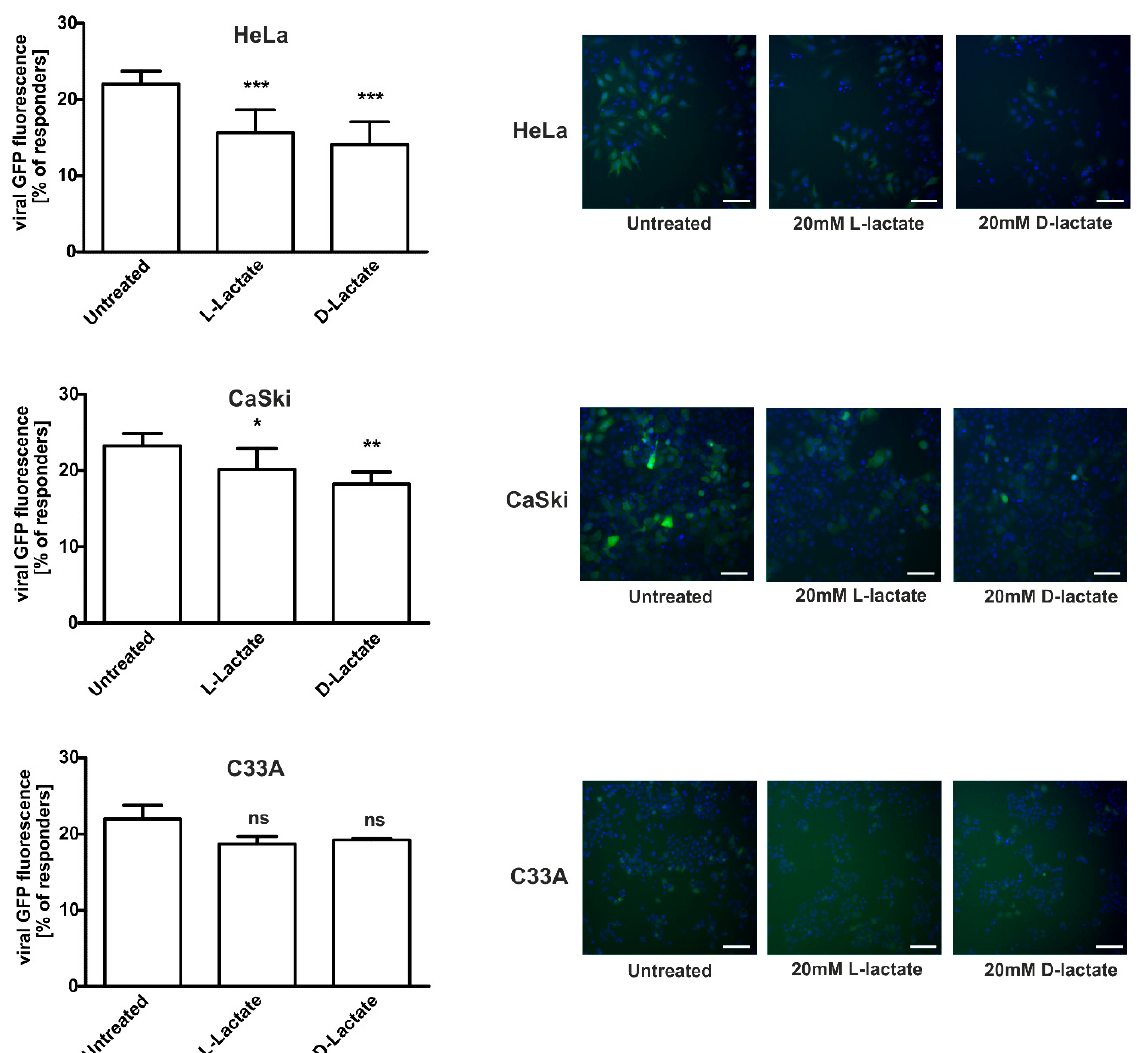
Figure 2. L- and D-lactate treatment affect the transduction efficacy of lentivirus. Cervical cancer cells were incubated in the presence or absence of 20 mM L- or D-lactate for 24 h, followed by infection with copGFP Control Lentiviral Particles at MOI = 5 for 24 h before changing the medium. After 48 h, the infected cells were stained with Hoechst 33342 and immediately analyzed using an ArrayScan VTI HCS Reader. The graphs show the percentage of high copGFP expressing HeLa, CaSki, and C33A cells (responders) whose fluorescence overcame the threshold of mean fluorescence set on untreated cells. Data are presented as mean ± SD (n = 3). Images showed representative microscopic areas for the particular treatment from the same experiment. * p < 0.05, ** p < 0.01 and *** p < 0.001; not significant, ns. The scale bar is 100 µm.